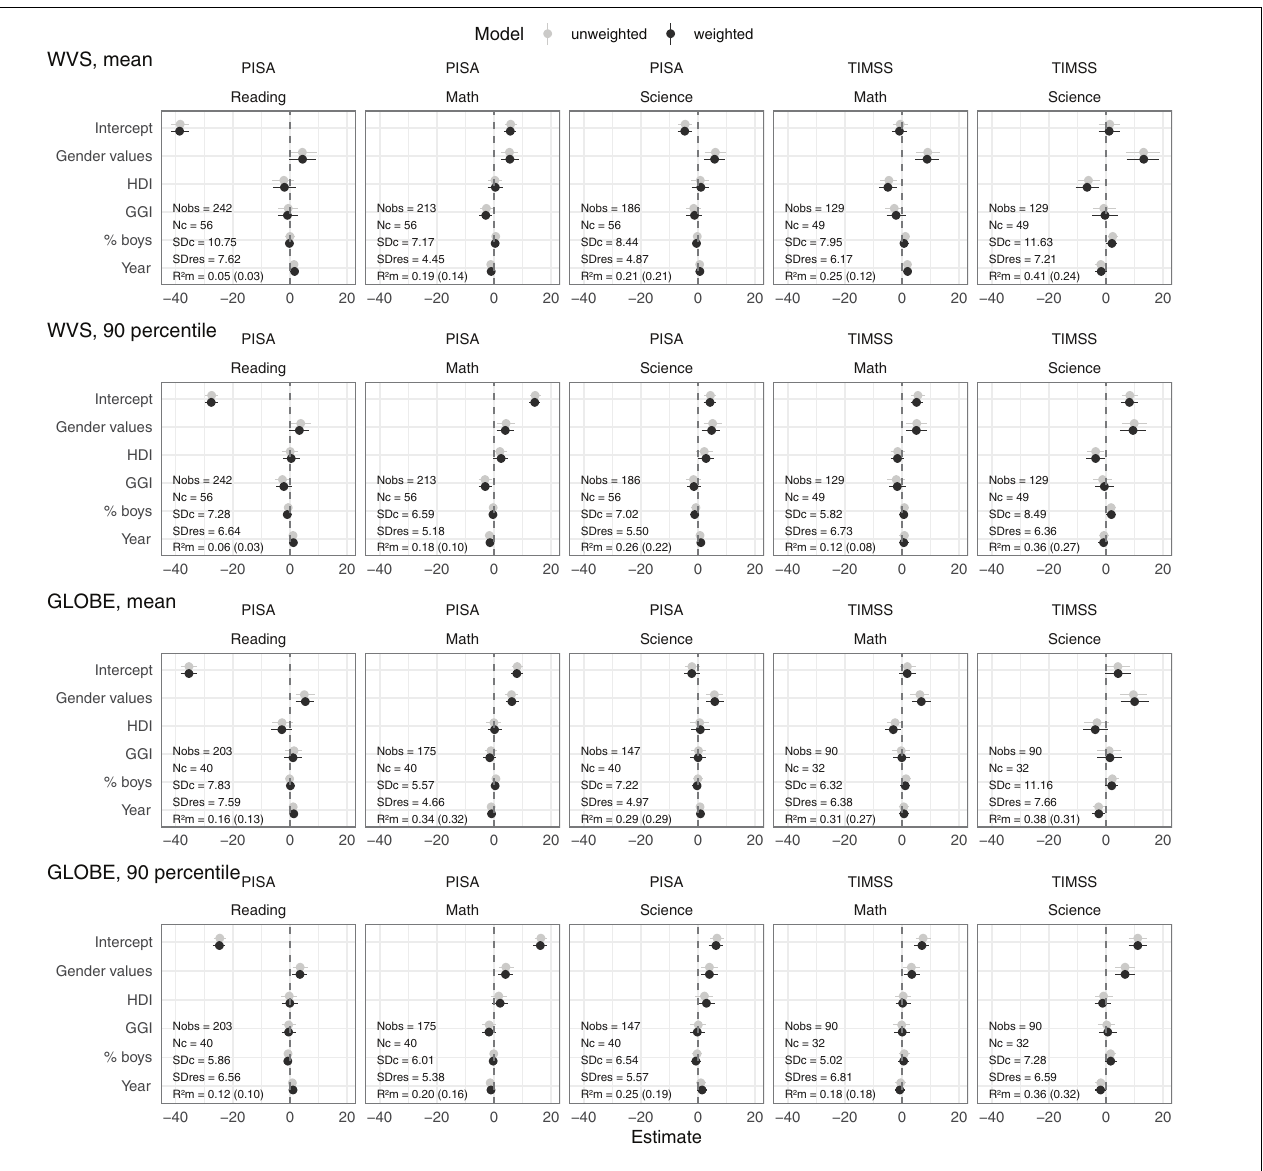
FIGURE 2 | Mixed effects models of gender egalitarian values and covariates on the mean and 90th percentile relative achievement of boys vs. girls. Note . The figure shows fixed effects with 95% bootstrap CI for weighted (dark) and unweighted (light) models. For the weighted models, we display the standard deviations of the random country intercept (SDc) and of residuals (SDres), as well as marginal R-squared (R2m). Marginal R-squared for gender values alone is included in parentheses. All models included random intercepts at country level. All independent variables are centered on the mean and standardized to have unit standard deviation. Entries estimate by how many points the relative achievement of boys vs. girls tends to increase when the corresponding independent variable increases by one standard deviation and the other variables are held constant. Collinearity was not at problematic levels; all variance inflation factors were less than or equal to 3.3.